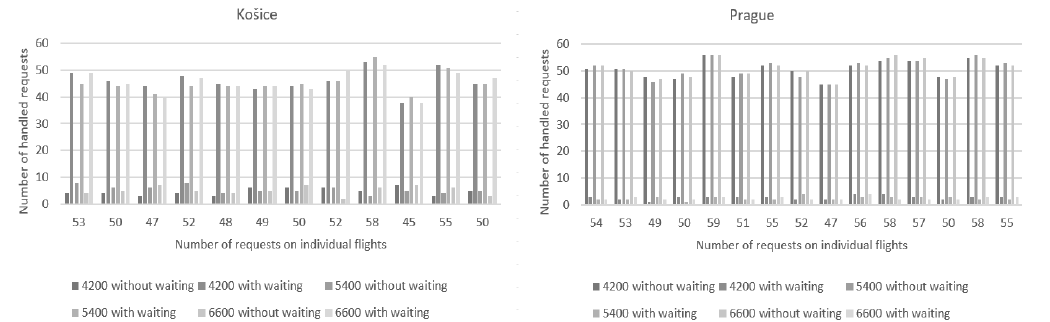
Figure 4. Number of handled requests at the airport in Košice and Prague.